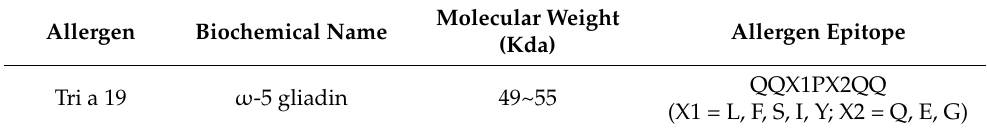
Table 1. Major allergen epitope in ω -5 gliadin